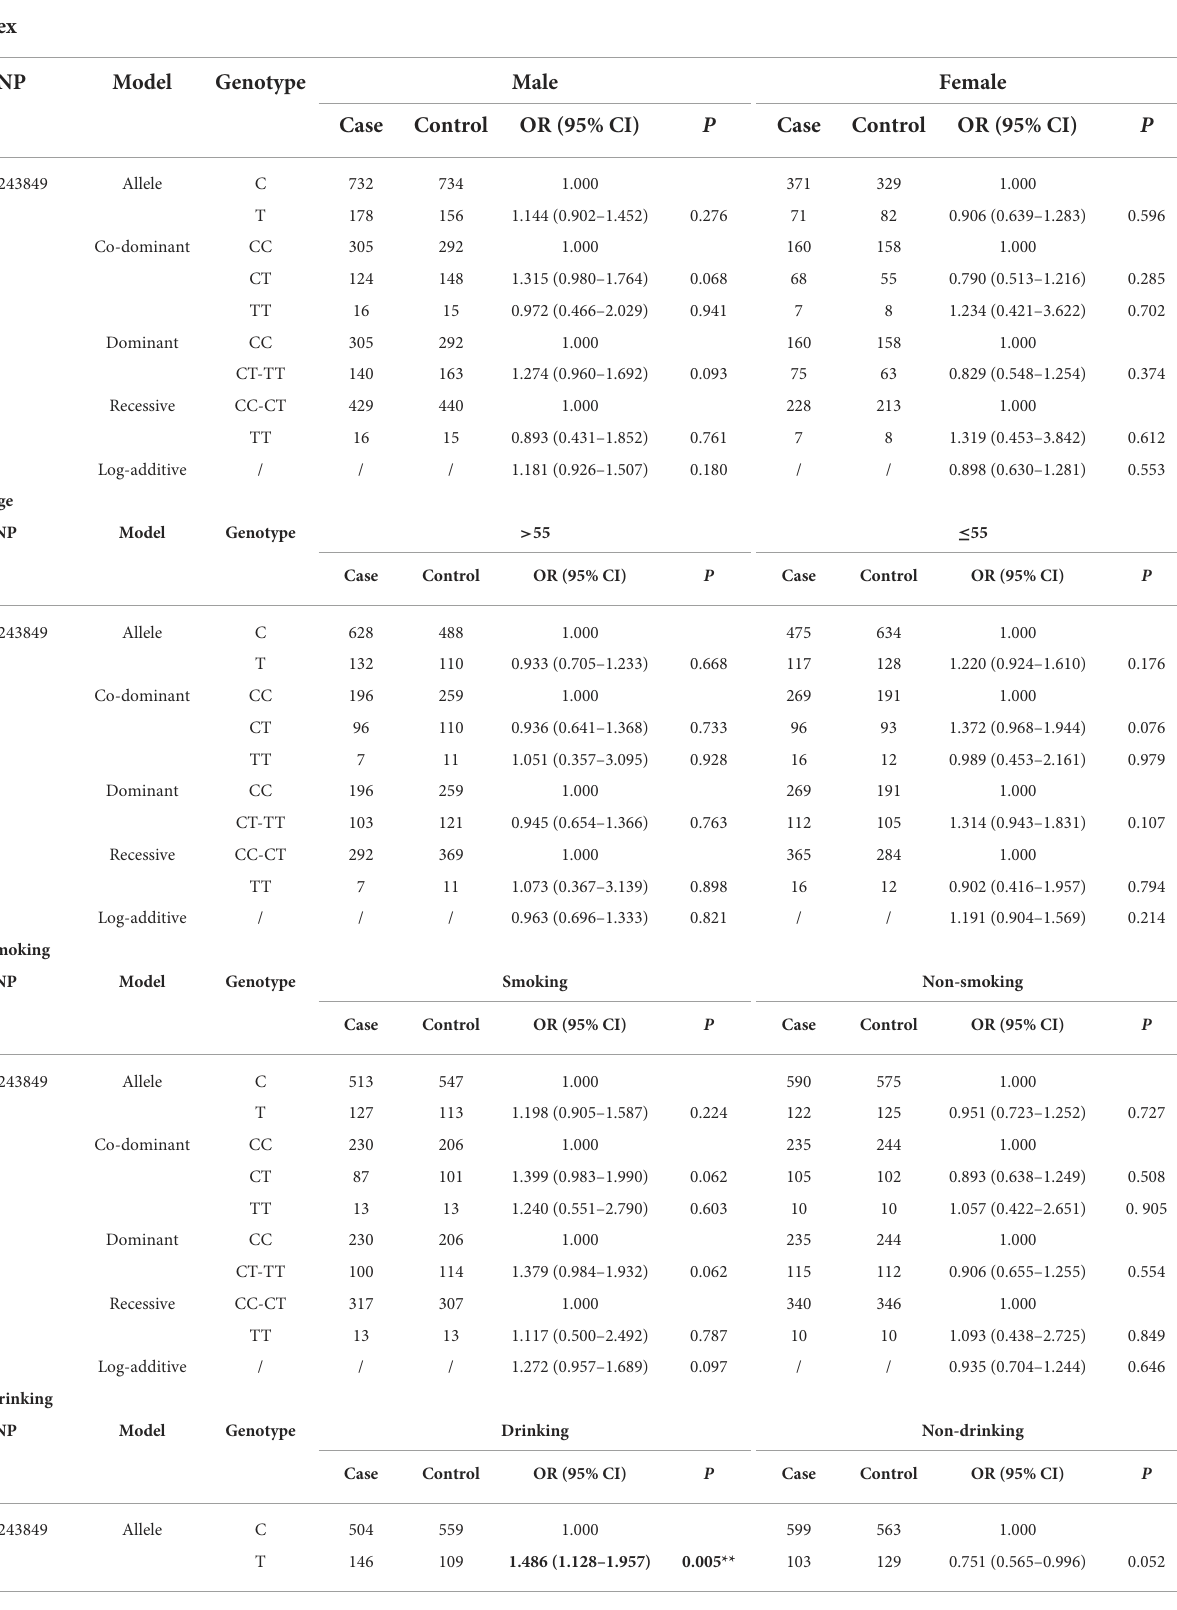
TABLE 4 Relationship between rs243849 of MMP2 and ischemic stroke in different